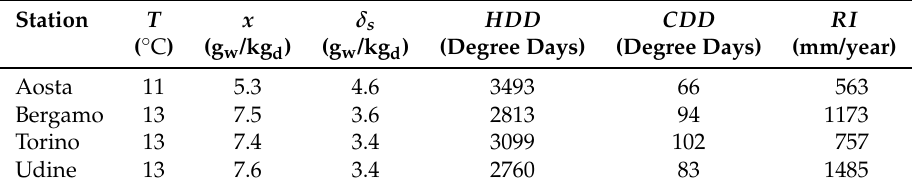
Table 2. Mean values of the weather variables for the whole weather records.